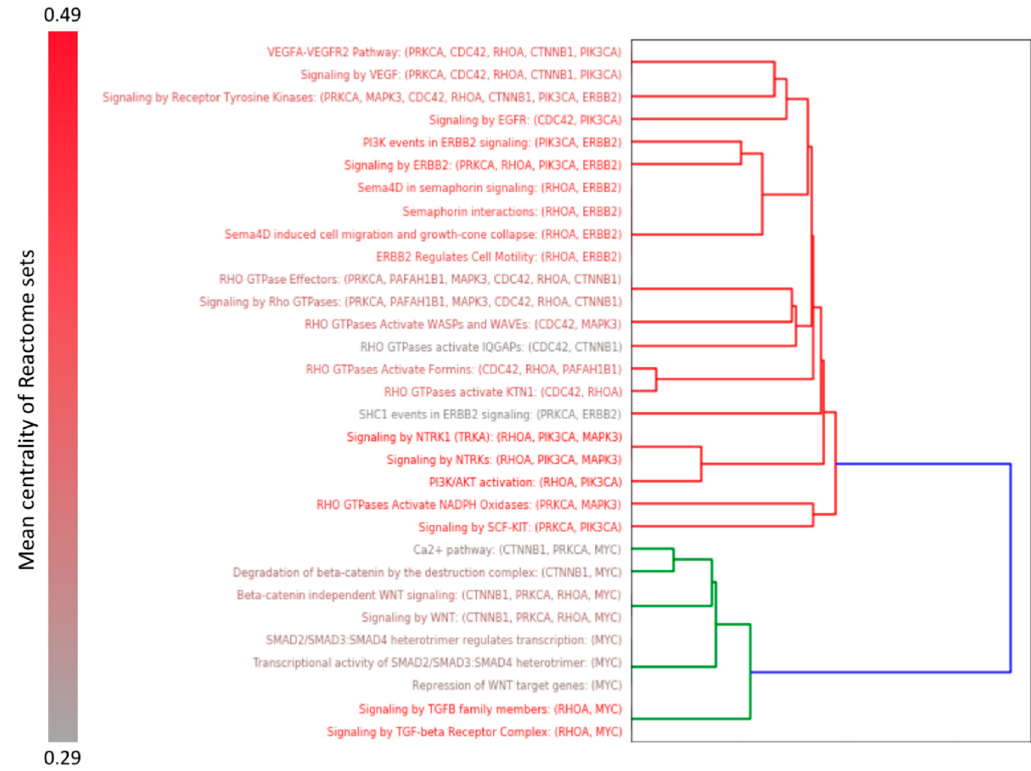
Figure 2. The dendrogram shows clusterization of Reactome pathways, in which the key miR-375 target genes are significantly overrepresented in the heart muscle. The clusters are shown in different colors. The red to gray gradient of text color (shown on the left) reflects the increase in the mean centrality of genes in sets.